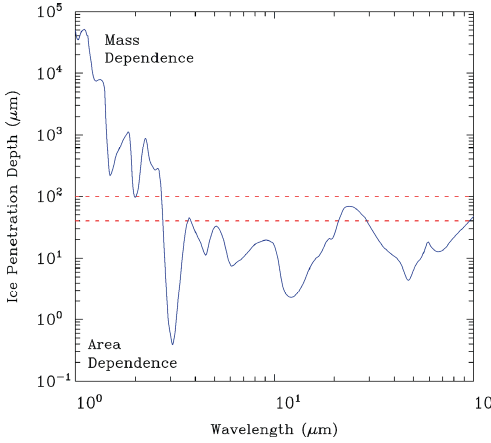
Figure 16. Wavelength dependence for the radiation penetration depth into bulk ice. The two Fig. 16. Wavelength dependence for the radiation penetration depth horizontal dashed lines represent D e for the two cases considered here. Regions of purely mass into bulk ice. The two horizontal dashed lines represent D e for and area dependent absorption are indicated. the two cases considered here. Regions of purely mass and area dependent absorption are